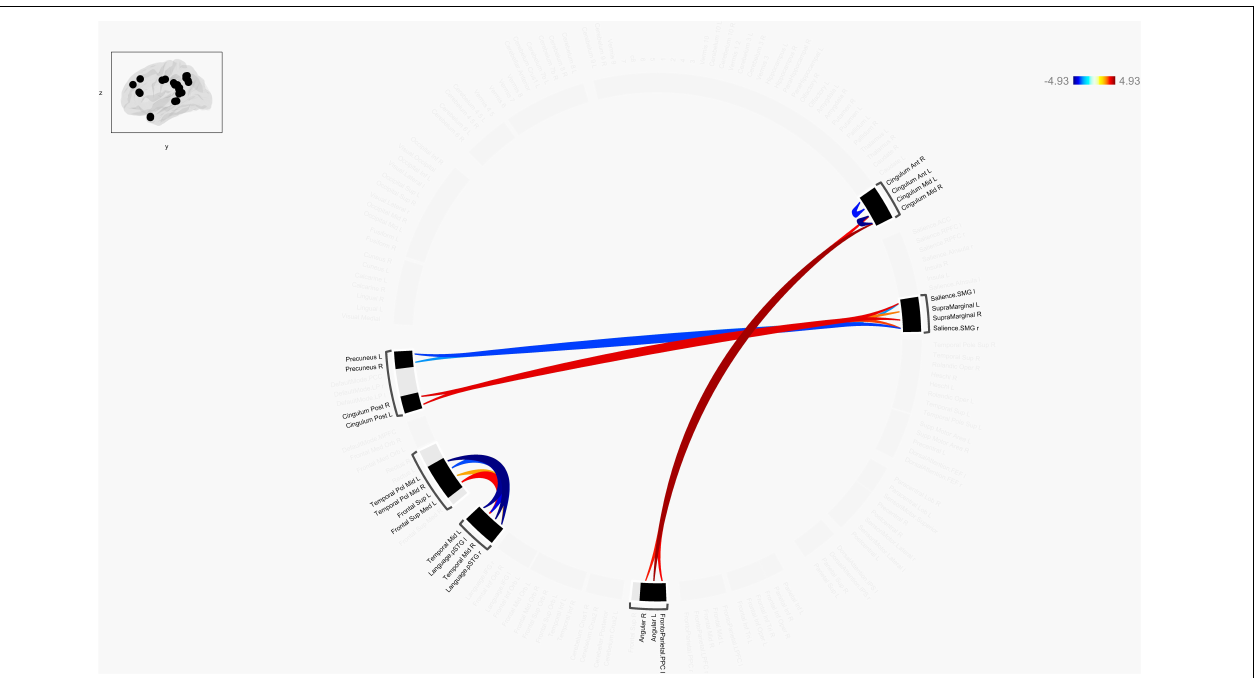
FIGURE 4 | Chord diagram of the ROI-to-ROI FC z-score showing significant group difference between TLE patients and HCs. The abbreviation outside the circle stand for the AAL cerebrum regions. The red line stands for increased FC and the blue line stands for decreased FC in TLE patients compared to HCs. Abbreviations: ROI, region-of-interest; FC, functional connectivity; TLE, temporal lobe epilepsy; HCs: Healthy